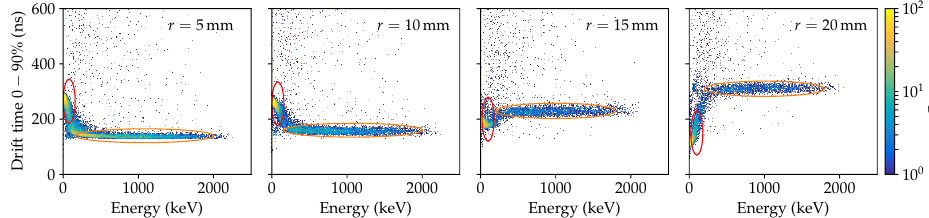
Figure 22. Predicted correlation between the drift time and energy E obs 90 Sr events. Simulation results are shown for the surface charge σ = vertical and orange horizontal ellipses in the distributions indicate two event